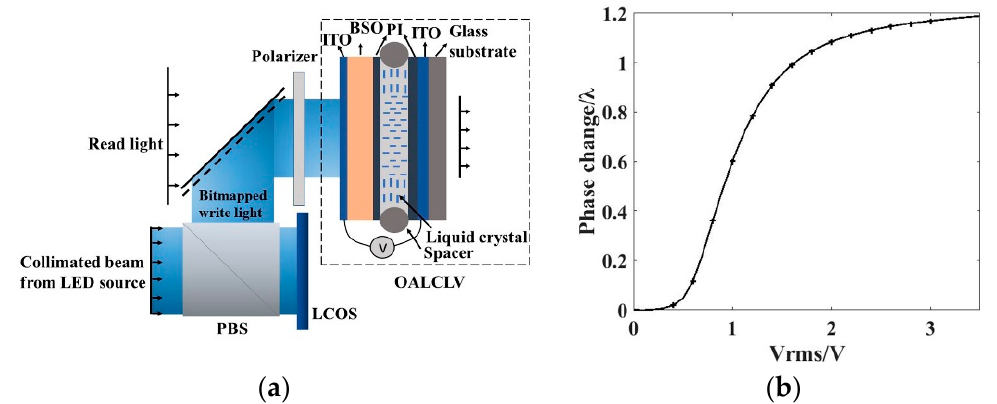
Figure 1. ( a ) Working principle of the optically addressable spatial-light modulator (OASLM) and structure of the optically addressable liquid-crystal light valve (OALCLV) consisting of the